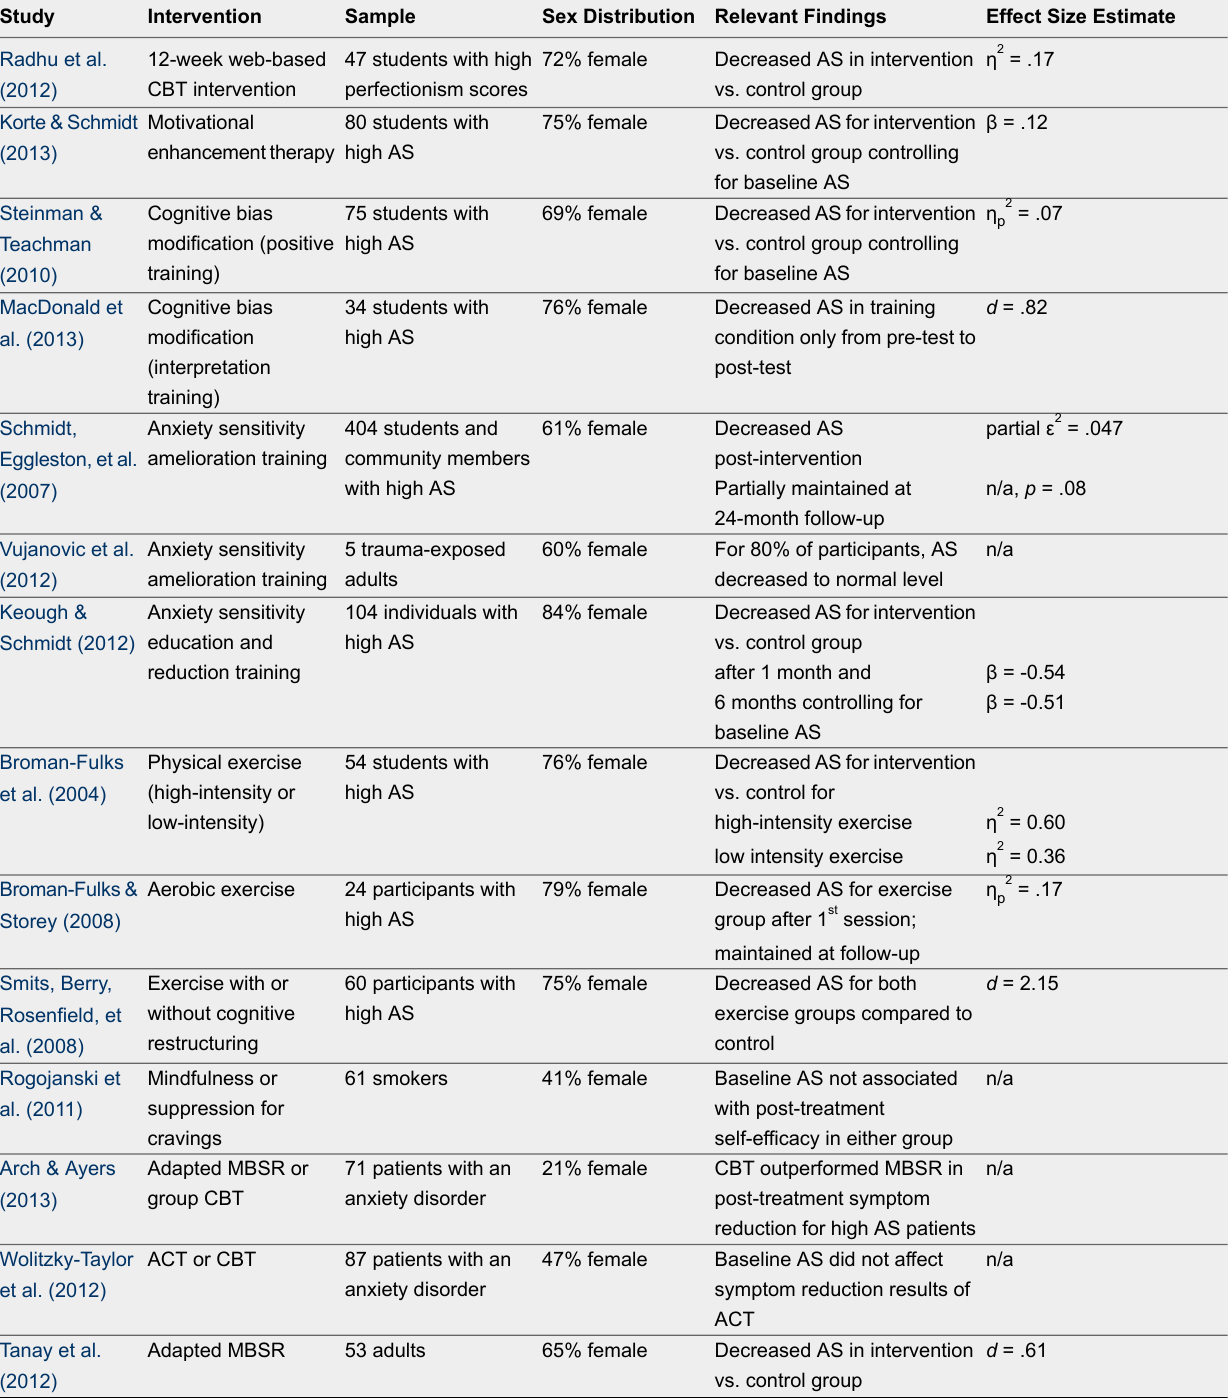
Summary of Psycho-Educational and Mindfulness-Based Interventions for